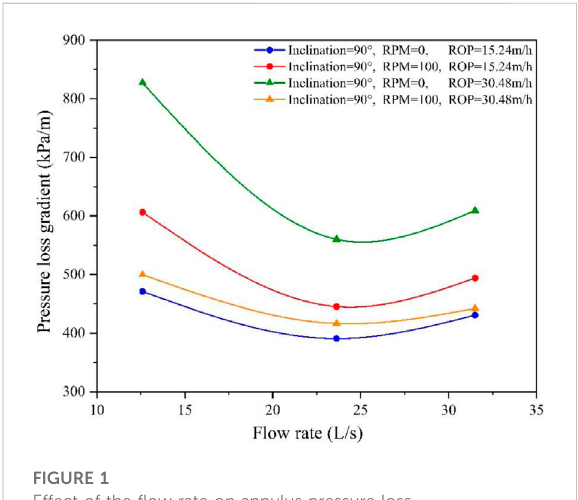
FIGURE 1 Effect of the fl ow rate on annulus pressure